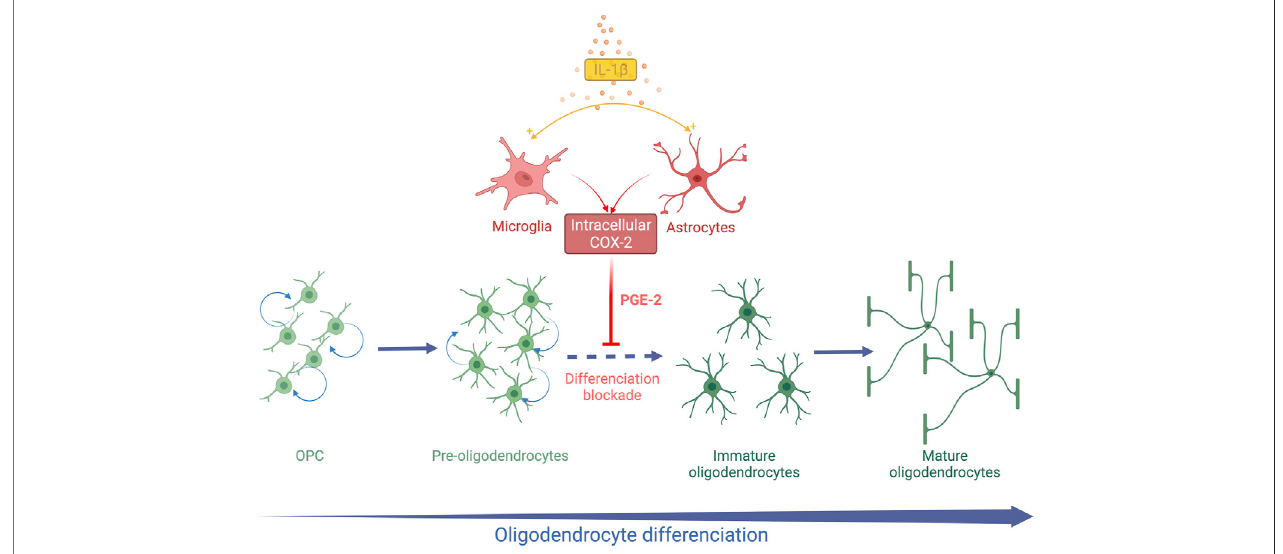
FIGURE 2 | Schematic representation of systemic IL-1 β action on OL lineage in the developing brain. Systemic Il-1 β acts through the activation of the cyclooxygenase2(COX2)-ProstaglandinE2(PGE2)pathwayinastrocytesandmicroglia.PGE2inducesanarrestofOLdifferentiationleadingtoanaccumulationofPre- OLs and a reduction in differentiated